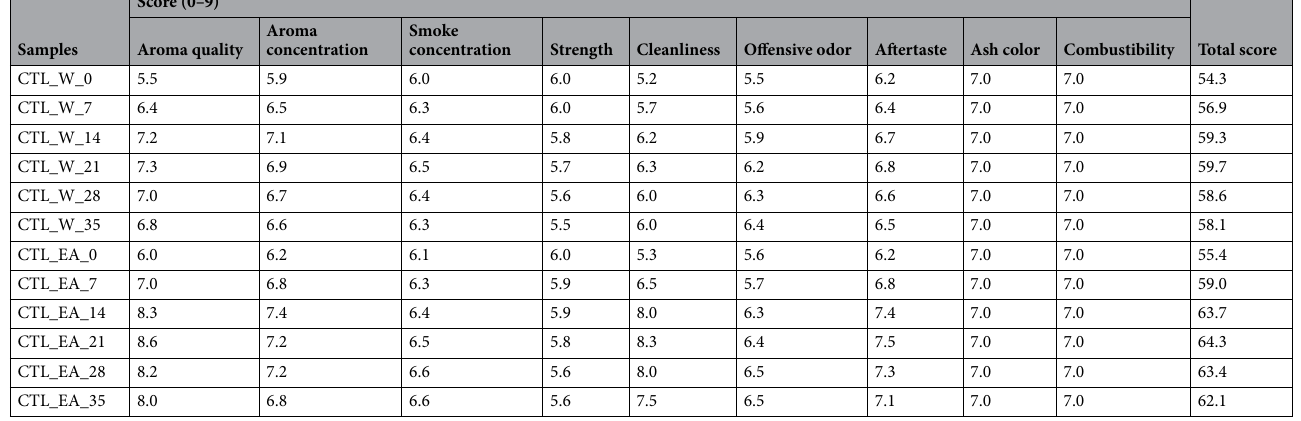
Table 1. Sensory evaluation results of CTL